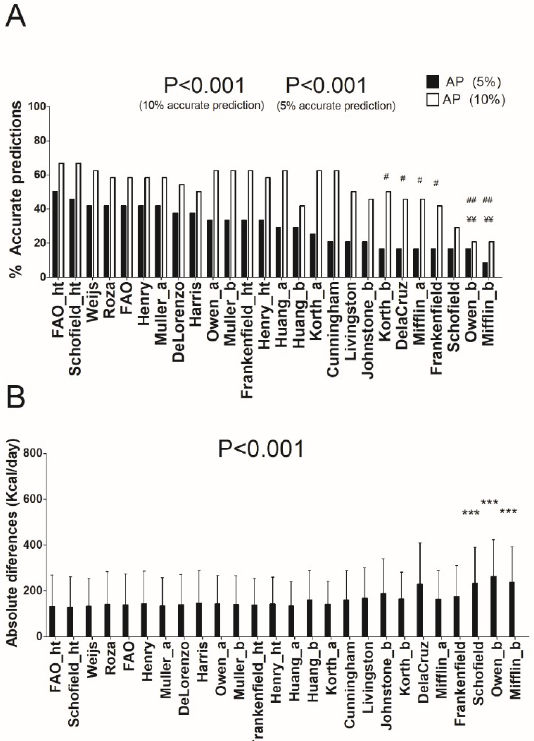
Figure 1. Percentage of accurate prediction of resting energy predictive equations and mean differences between predicted and measured resting energy expenditure in absolute values in normal-weight individuals. ( A ) Percentage of prediction accuracy at 5% and 10% of resting energy expenditure. ( B ) Mean (SD) differences between predicted and measured resting energy expenditure in absolute values; p value of repeated measures analysis of variance (with Bonferroni post-hoc analysis) among the predictive equations; * = p < 0.05; ** = p < 0.01; *** = p < 0.001 when compared with the predictive equation that presented the least absolute differences with respect to the measured resting energy expenditure (FAO_ht); ¥ = p < 0.05; ¥¥ = p < 0.01; ¥¥¥ = p < 0.001 when compared with the predictive equation that presented the best resting energy expenditure prediction accuracy (10%) with respect to the measured resting energy expenditure (FAO_ht); # = p < 0.05; ## = p < 0.01; ### = p < 0.001 when compared with the predictive equation that presented the best resting energy expenditure prediction accuracy (5%) with respect to the measured resting energy expenditure (FAO_ht). AP: Accurate prediction; “_a” refers to predictive equations which require only anthropometric parameters to calculate REE, “_b” refers to predictive equations which require body composition parameters to calculate REE, and “_ht” refers to predictive equations which are proposed by the same author and include height.